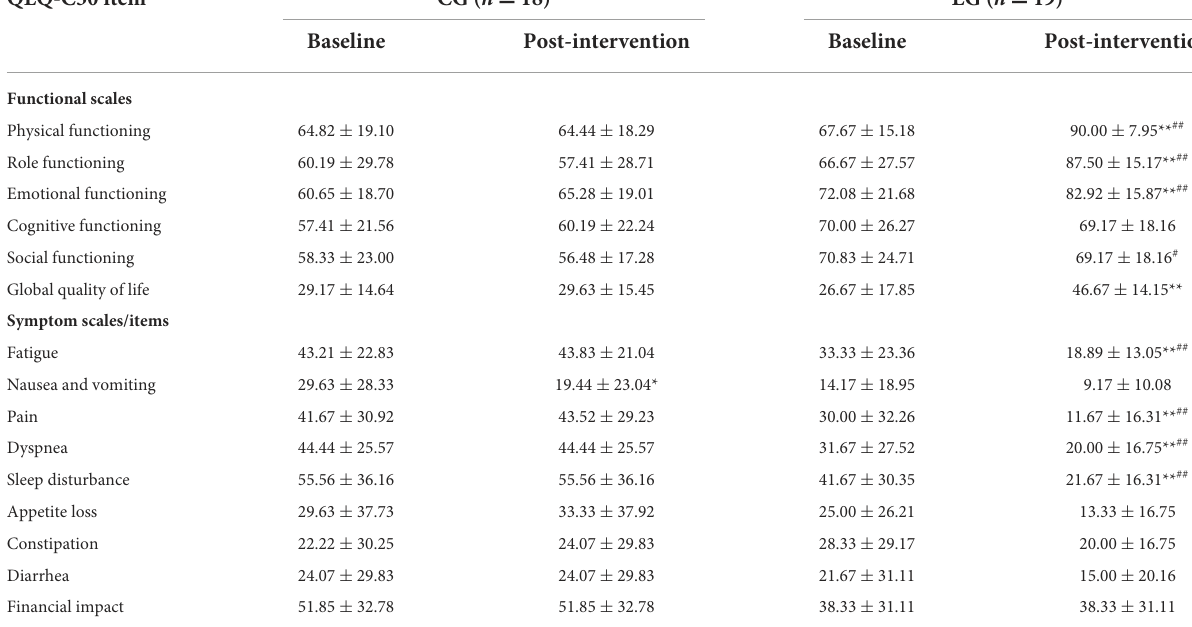
TABLE 5 The QLQ-C30 scores of the CG and the EG.